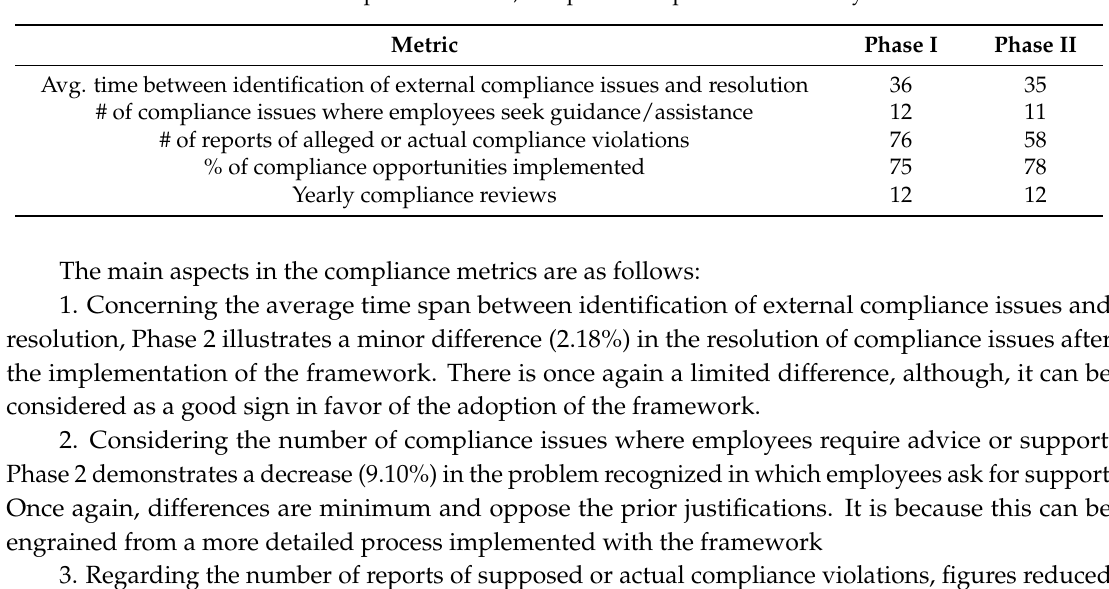
Table 6. Compliance metrics, comparison of phases. Case Study 2.